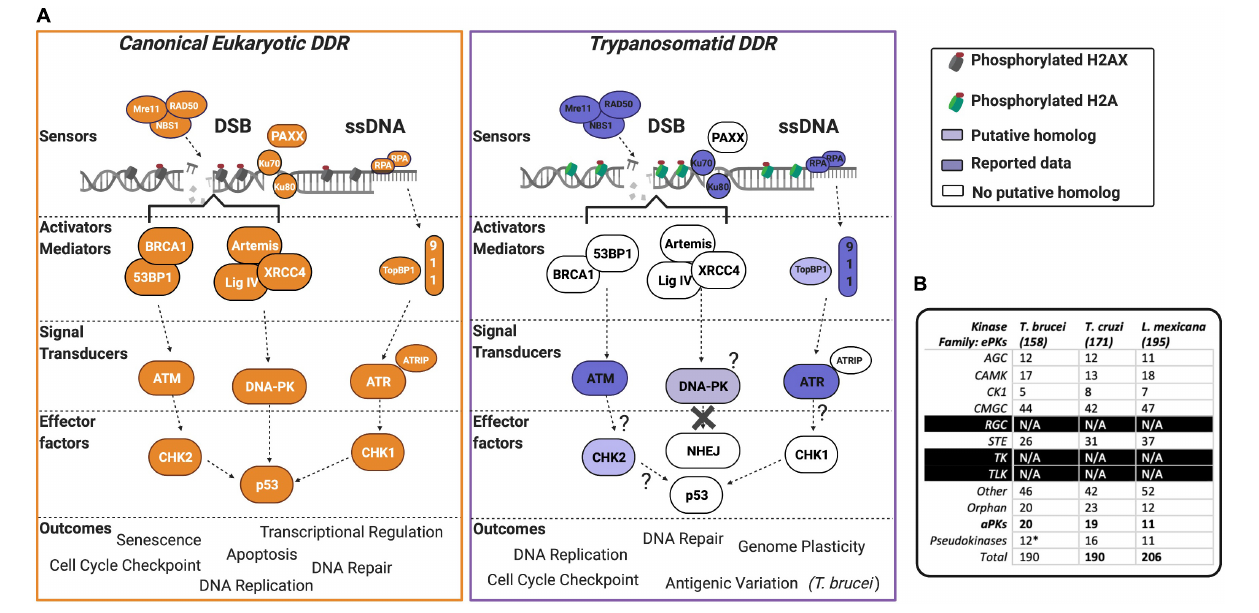
FIGURE 2 | The PIKK-driven DDR pathways in Trypanosomatid parasites and the canonical Eukaryotic pathways. (A) A schematic illustration of a simplified eukaryotic DDR pathway (left) compared to known or predicted components of the trypanosomatid DDR pathway (right). Dark shaded factors indicate that functional characterization has been performed in one or more organisms. Light shading indicates limited data availability. White indicates no data are available or the factor is not present in the genome, as further illustrated by question marks. For more intricate details on eukaryotic DDR factors and pathways, we encourage the reader to refer to recent reviews (Alexander and Orr-Weaver, 2016; Blackford and Jackson, 2017; Wright et al., 2018; Sun et al., 2020; Zhao et al., 2020; Ghosh and Raghavan, 2021). DSB, double-stranded break; DDR, DNA damage response; ssDNA, single-stranded DNA. (B) Summary table of PKs and their associated families in T. brucei , T. cruzi , and L. mexicana . Data collated from Parsons et al. (2005), Jones et al. (2014), and Baker et al. (2021). (*) = the pseudokinases in T. brucei are included among the counts for the other families and their respective numbers have not been adjusted to remove pseudokinase family members. N/A = no kinases have been identified as members of these kinase